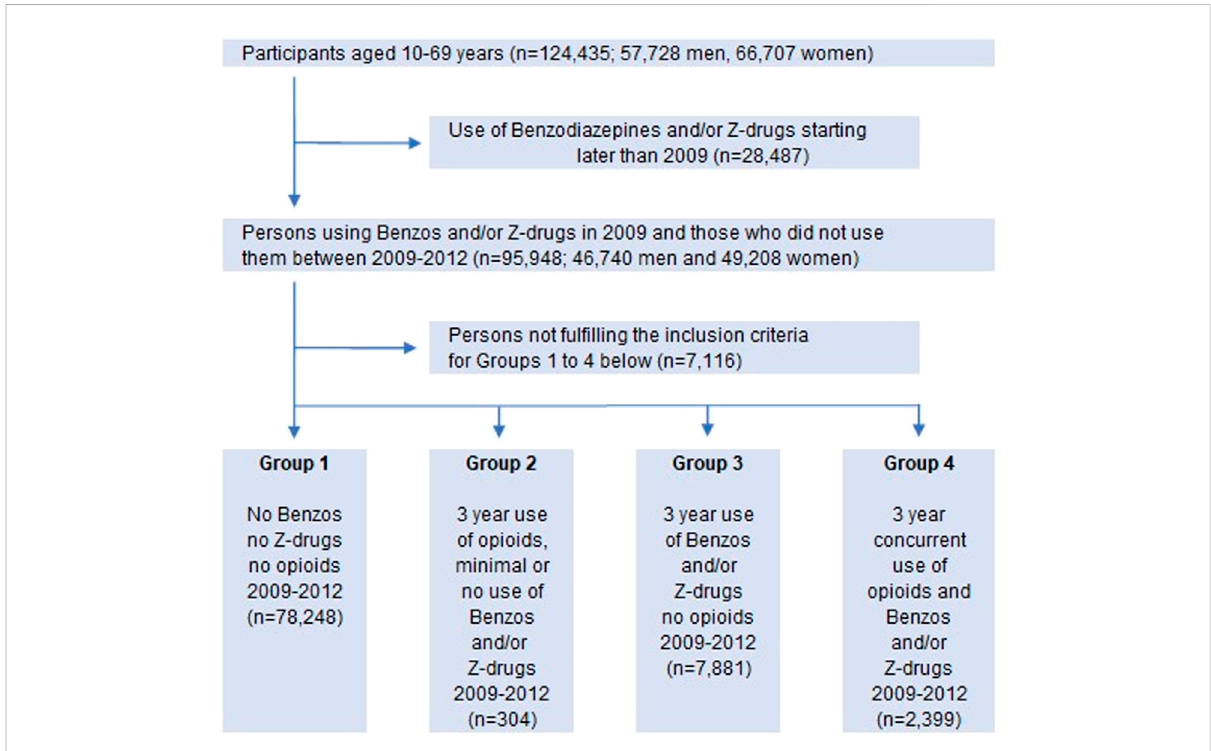
FIGURE 2 Flow chart of participants divided into four groups according to different prescribing/(use) of benzodiazepines, Z-drugs and opioids. Vertical arrows: included; horizontal arrows: excluded.